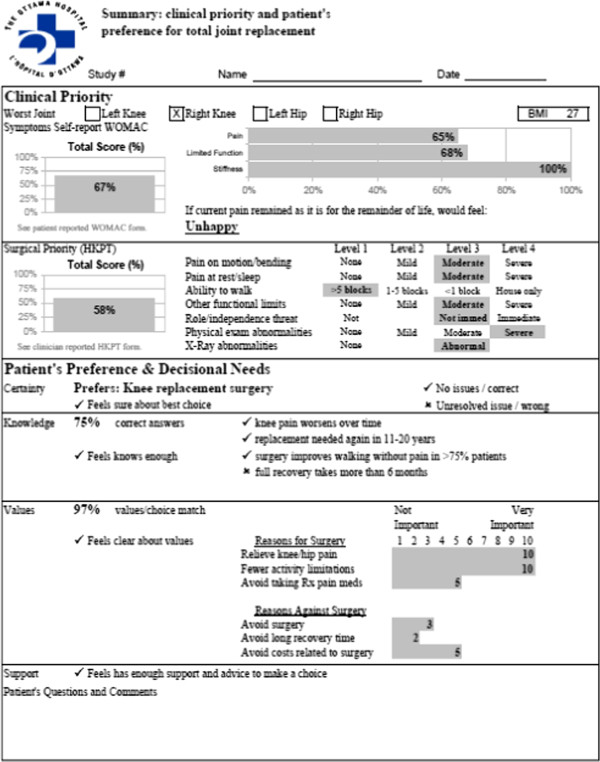
Summary report for surgeons [26].